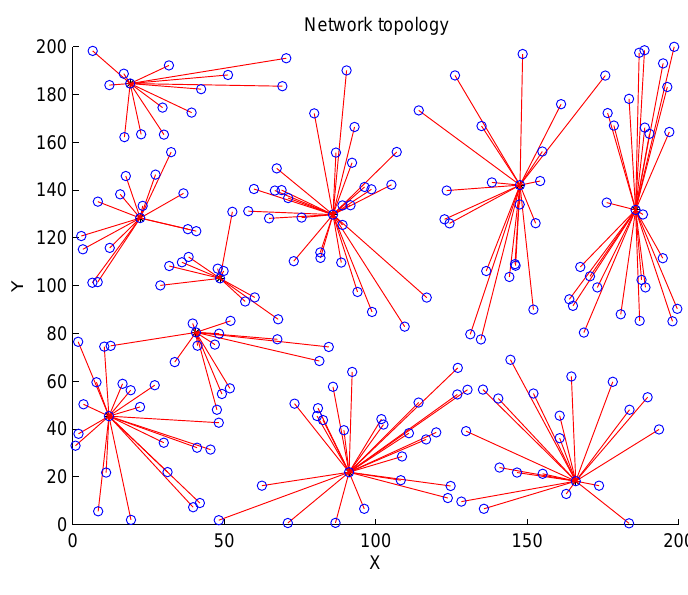
Figure 11. Cluster formation of REEMR.